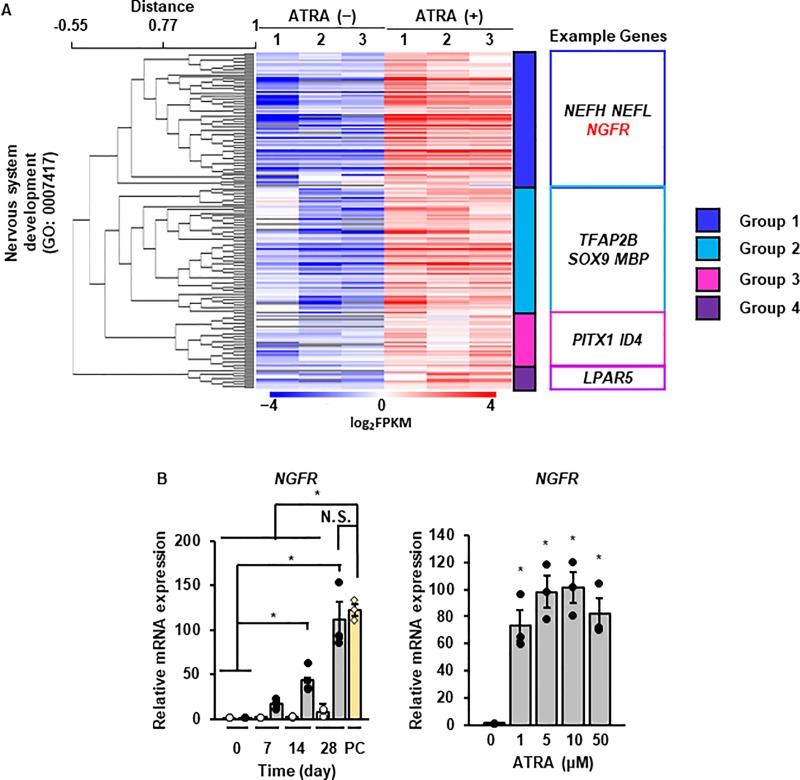
NGFR as a marker for ATRA-induced neuronal reprogramming.(A) Heat map showing unsupervised hierarchical cluster analysis of up-regulated genes (P < 0.05) under GO terms of nervous system development. The number above the heat map indicates independent biological replicates. Example genes (right) of each group are shown. Red and blue indicate up-regulated and down-regulated genes, respectively. (B and C) Time (B) and dose (C)-dependent changes in NGFR mRNA in DFATs treated with ATRA at the indicated time points and the indicated concentration of ATRA. Data are shown as the mean ± standard error of three independent experiments. *P < 0.05, compared with 0 day (B) or 0 μM (C).